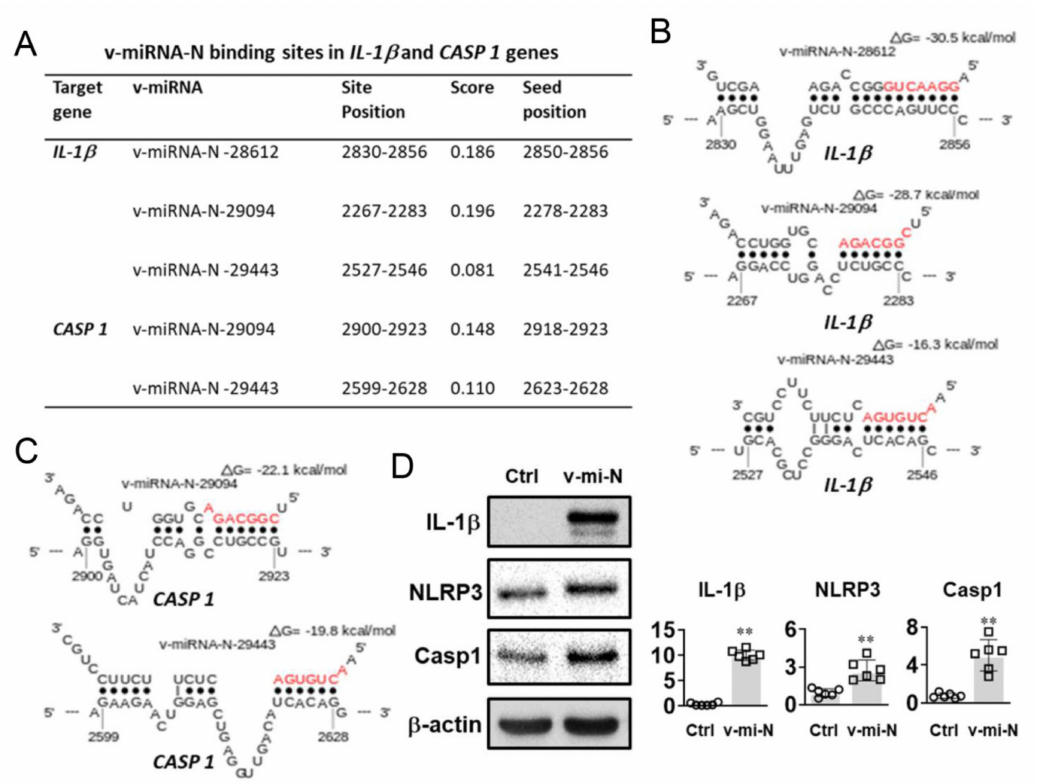
Figure 3. Putative interactions of SARS-CoV-2 v-miRNA-N were found in host genes related to inflammasome activation. ( A ) A summary of the binding sites of v-miRNA-N-28612, v-miRNA-N-29094, and v-miRNA-N-29443 in the 3 (cid:48) UTR sites of IL- 1 β and CASP 1 gene. ( B ) and ( C ) show the binding sites for v-miRNA-N-29094 and v-miRNA-N-29443 in the 3 (cid:48) UTR regions of IL-1 β and CASP 1 gene, which are analyzed using Sfold STarMir (https://sfold.wadsworth.org/cgi-bin/starmirtest2.pl) (accessed on 25 May 2021). The seed sequences of v-miRNA-N species are shown in red. ( D ) Western blot results show the expression of IL-1 β , NLRP3, and caspase 1 (Casp1) proteins in PBMCs transfected with negative control (Ctrl; leftside) or v-miRNA-N (v-mi-N; rightside) synthetic mimics. n = 6 (obtained from biological replicates); ** p < 0.01. CASP 1 , caspase 1; IL-1 β , interleukin one beta; NLRP3, nucleotide oligomerization domain-like receptors family pyrin domain containing 3; v-miRNA-N, viral microRNA